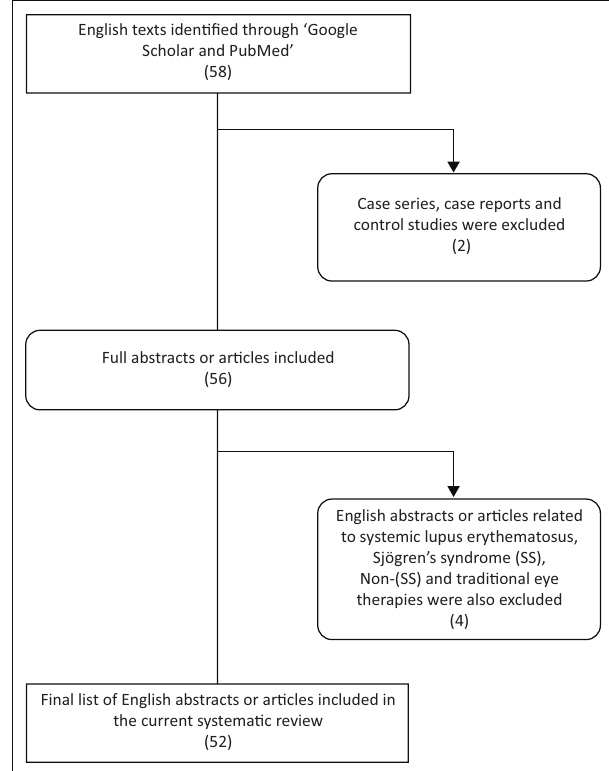
FIGURE 1: Search mode: Main keywords.